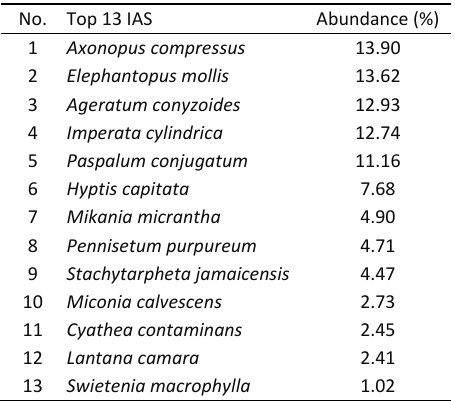
Table 4. Top 13 alien species of plants in Site 1 and Site 2, Mt. Table 4: Top 13 alien species of plants in Site 1 and Site 2, Mt. Manungal, Cebu Island, Philippines. Manungal, Cebu Island,